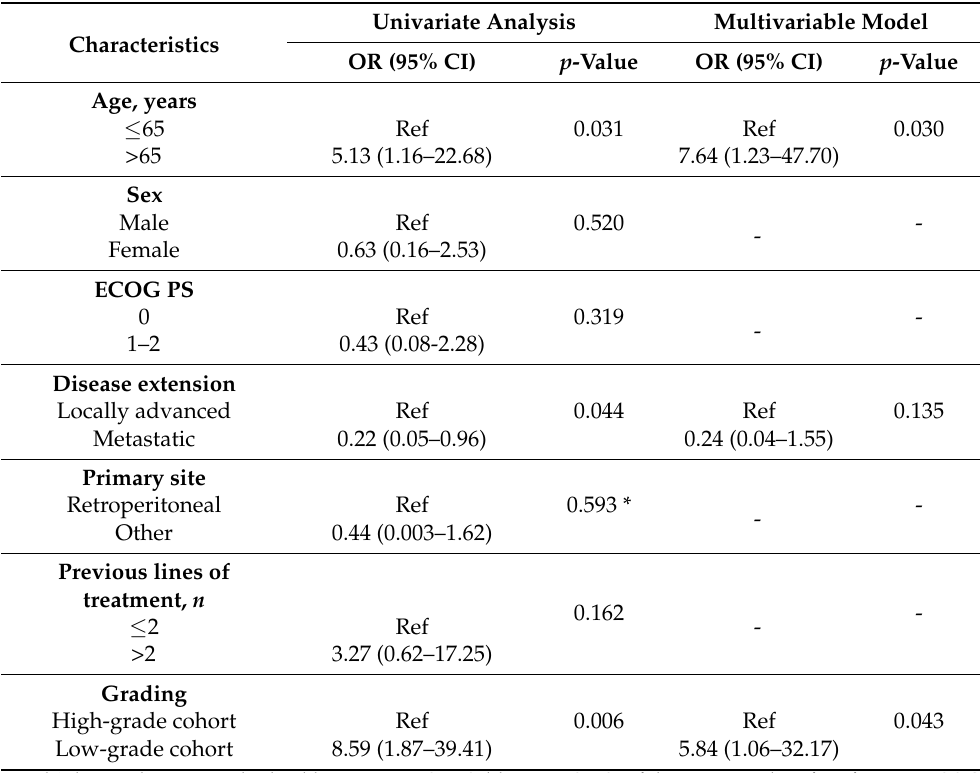
Table 3. Logistic regression analyses for objective